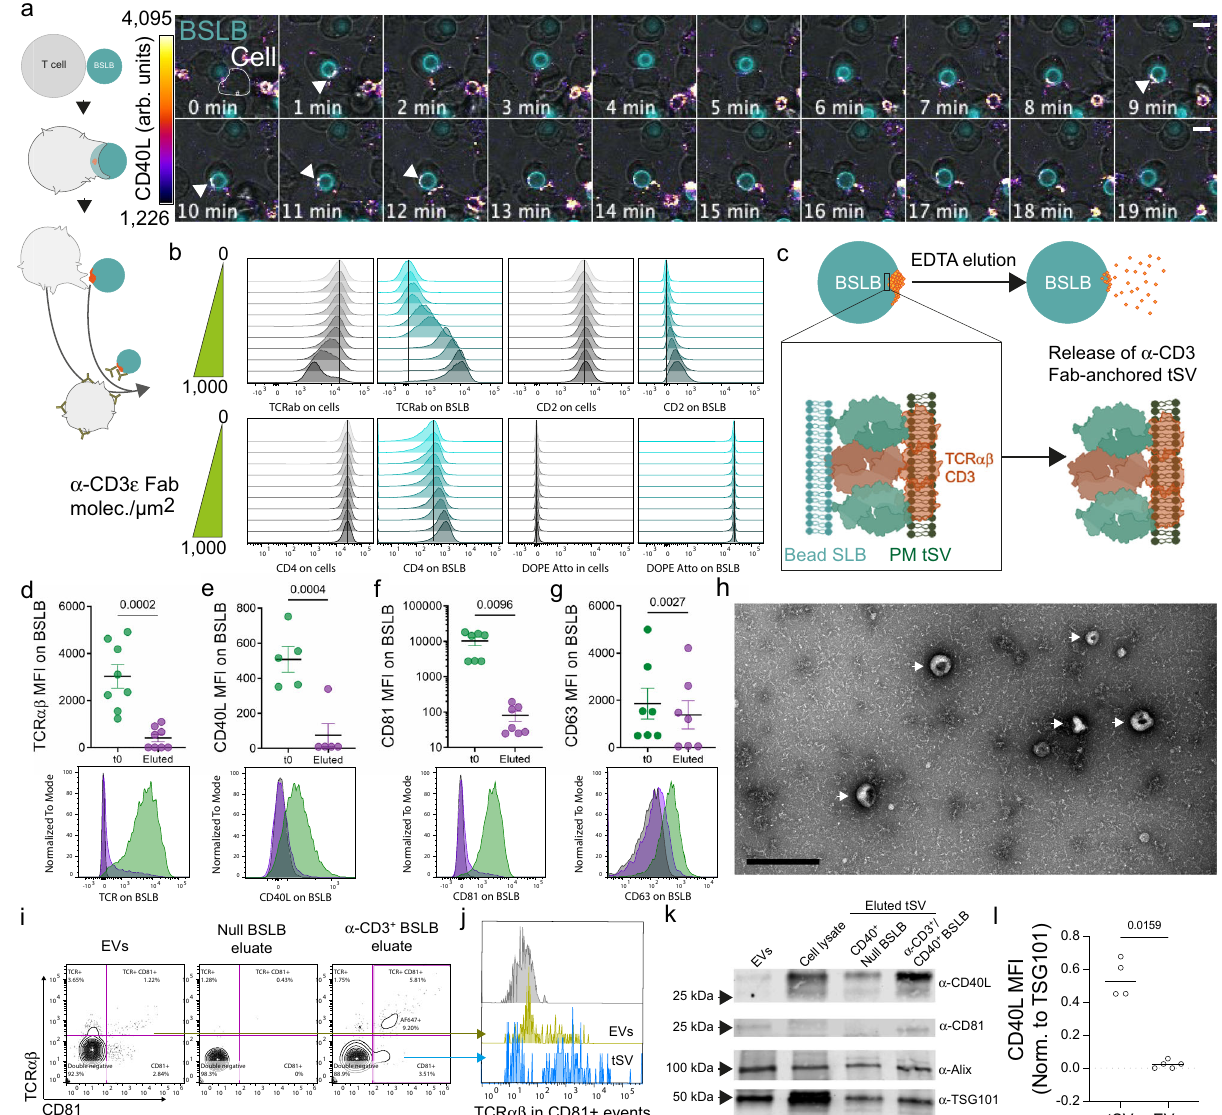
Fig. 1 As synthetic APC, BSLBs trigger synapse formation and the release of tSV by stimulated T cells. a Time-lapse confocal microscopy showing the interaction between TH and BSLB and the active transfer of CD40L + synaptic stamps to BSLB (white arrowheads). CD40L was tracked using 1 µ g/mL of anti-CD40L clone 24 – 31. Scale bar = 5 µ m; arb. units = arbitrary fl uorescence units. b FCM analyses of vesicular transfer from TH (gray histograms) to BSLB (teal histograms) presenting 2-fold titrations of α -CD3 ε Fab (0 – 1000 molec./ µ m 2 ) ICAM1 (200 molec/ µ m 2 ) and CD40 (20 molec/ µ m 2 ). Vertical lines indicate the median of cells and BSLB in the condition with no α -CD3 Fab (null). c After conjugate separation by cold, tSV are released from BSLBs with the use of 50 mM EDTA. d – h Elution results in the release of d TCR + , e CD40L + , f CD81 + , and to a lesser extent g CD63 + tSV, from the surface of BSLB as measured by FCM staining comparing null BSLB (black histograms), with BSLBs prior to (green), and after elution (violet). h Transmitted electron microscopy of eluates reveals the presence of tSV (white arrows) and small soluble proteins. Scale bar = 500 nm. i Representative NanoFCM analyses showing the detection of TCR αβ + and CD81 + events in isolated EVs (left panel), and the eluted material from Null BSLB (middle panel) and α -CD3 + BSLB (tSV, right panel). j Overlaid histograms showing TCR αβ expression on CD81 + vesicles from EVs (yellow) and tSV (light blue) compared to double negatives (gray). k Immunoblot for comparison of CD40L, CD81, Alix, and TSG101 in EVs and eluted tSV deriving from 5 × 10 6 of either cells or BSLB, respectively. Whole-cell lysate represents a total of 2.25 × 10 5 cells. The bands shown are from the same immunoblot membrane. l CD40L levels in eluted fractions (tSV) and EVs as measured by immunoblot (shown is CD40L normalized to TSG101). Normality was determined using Shapiro – Wilk test and statistical signi fi cance was determined by the two-tailed unpaired t test ( d – g ) and by the unpaired, two-tailed Mann – Whitney test ( l ). Data represents mean ± SEM of n = 2 ( a , i – j ) and n = 4 independent experiments ( b , e – h , k – l ). Uncropped and unprocessed versions of the immunoblots shown in k are available as source